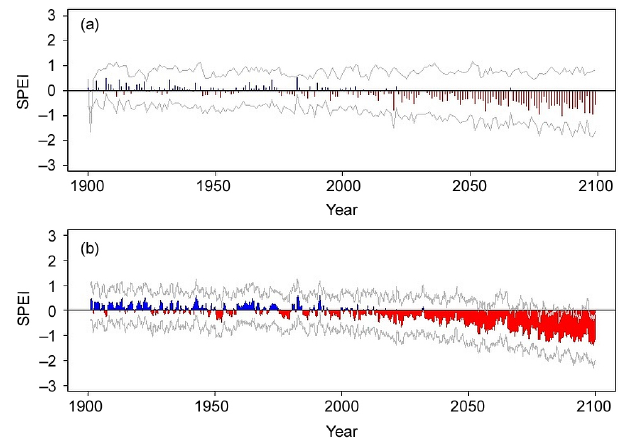
Figure 10. CMIP5 29-model ensemble medians of projected (a) summer (JJA) and (b) annual SPEI for RCP8.5 from 1900 to 2100 over the southern Prairies (defined in Sect. 2). Negative (red) values indicate surface water deficit relative to 1950–2005 condi- tions. Grey lines denote the 25th and 75th